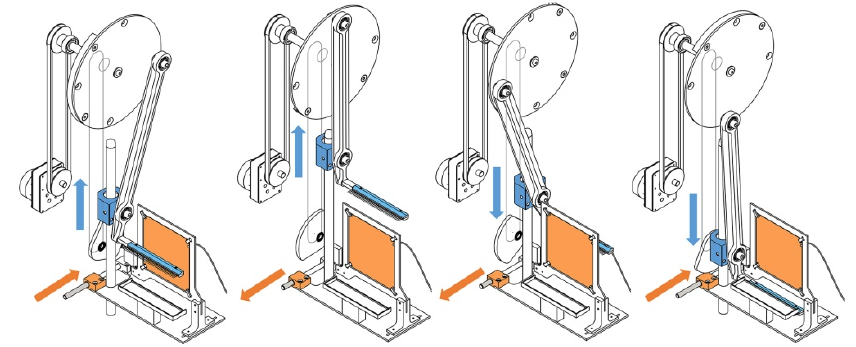
Figure 2. Motion steps of fiber formation.